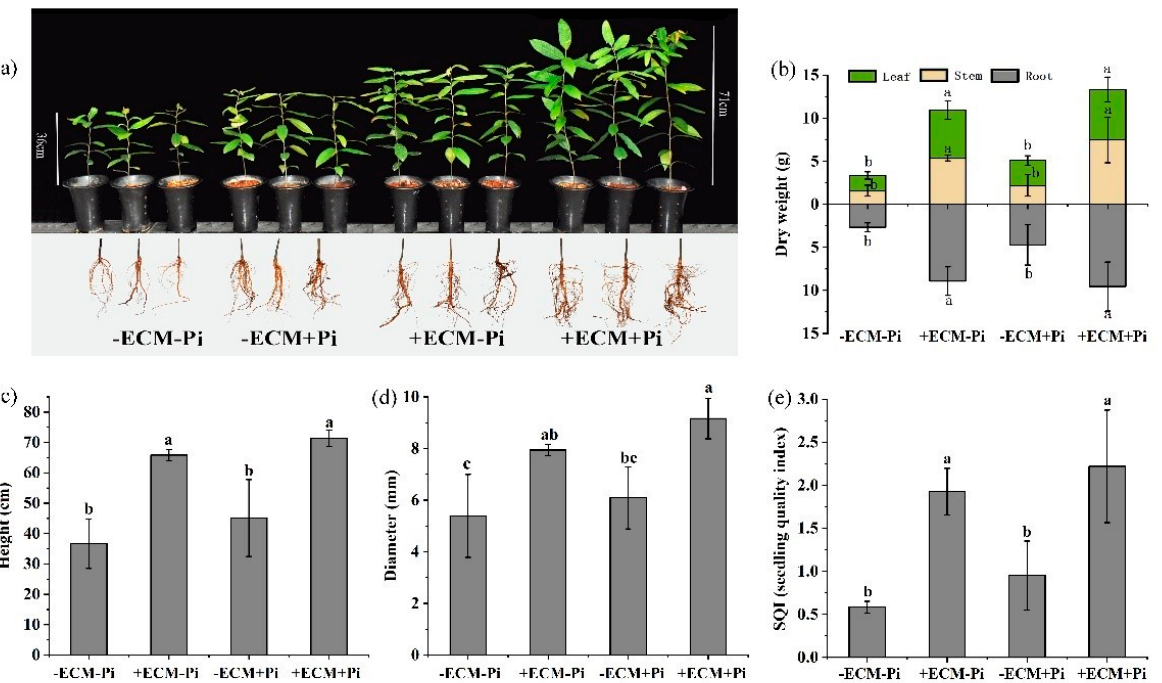
Figure 2. The effects of ECMF and Pi levels on dry weight, height, base diameter, and SQI of the C. henryi seedlings. -ECM-Pi: uninoculated and low Pi; -ECM+Pi: uninoculated and high Pi; +ECM-Pi: inoculated and low Pi; +ECM+Pi: inoculated and high Pi. ( a ) Visual comparison of C. henryi seedlings growth status of shoot (stem and leaf) and root; ( b ) dry weight of leaf (green), stem (yellow) and root (grey) of each treatment; ( c ) plant height of each treatment; ( d ) plant base diameter of each treatment; ( e ) SQI (seedling quality index) of each treatment. The error bars refer to standard deviation. For each figure, different letters indicate significant differences ( p < 0.05) according to Duncan’s multiple range test.